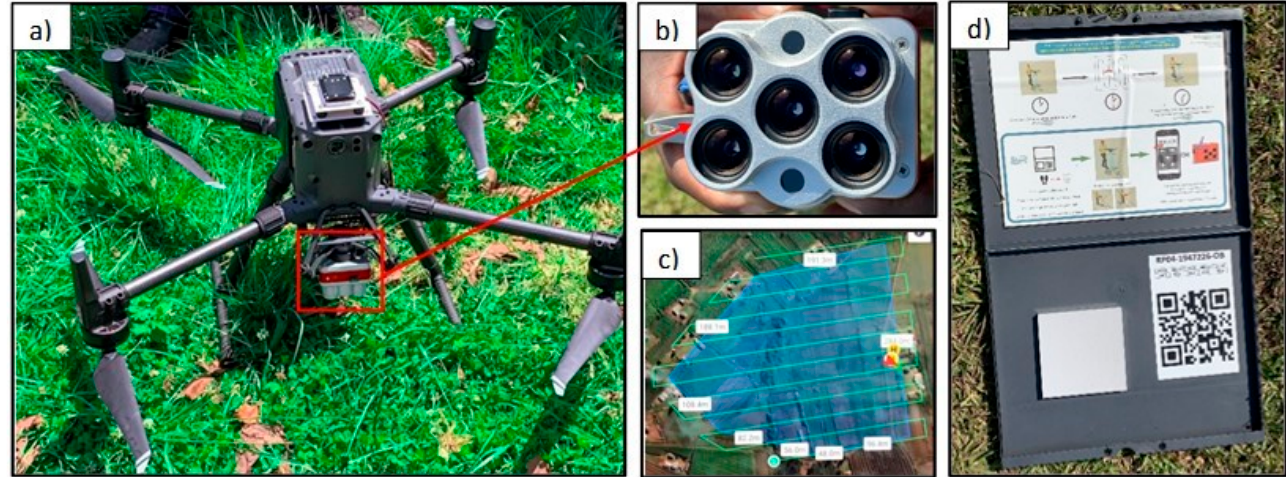
Figure 2. ( a ) Matrice 300 UAV integrated with the Altum sensor serving as the imaging platform used in this study, ( b ) Altum camera, ( c ) flight plan for the study image, and ( d ) the calibrated reflectance panel. Table 2. DJI M300 UAV specifications.